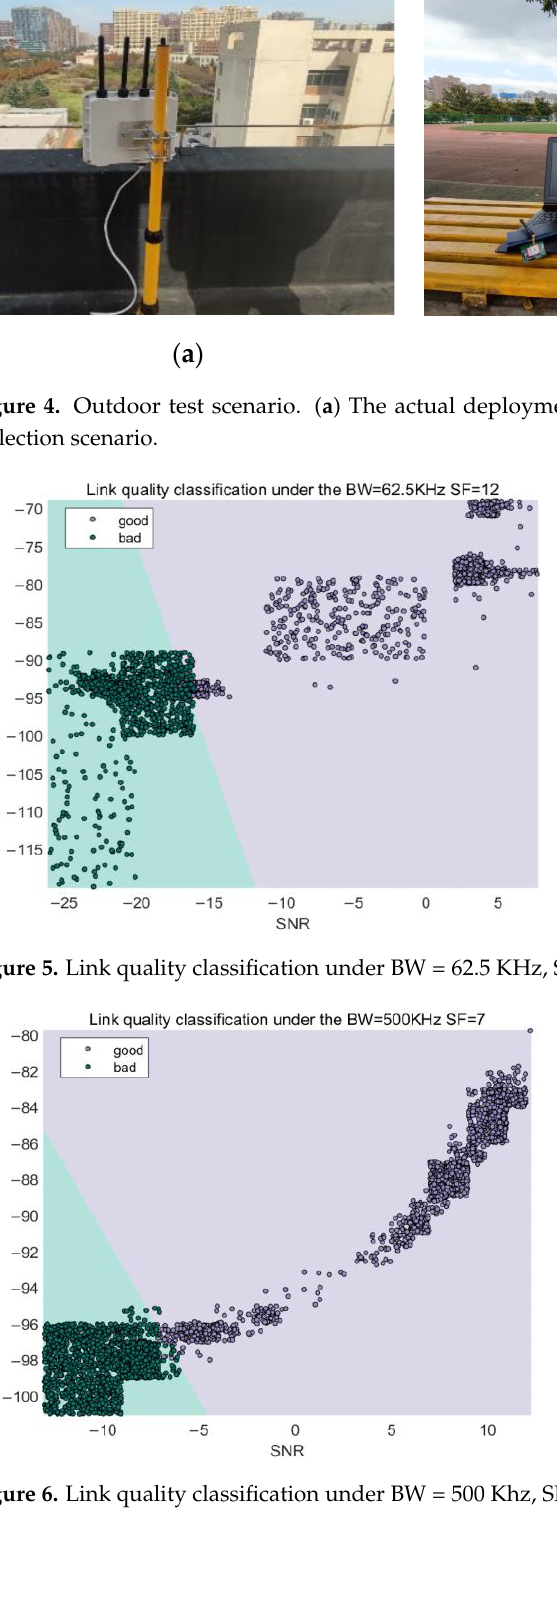
( b ) Figure 7. The optimization process of the model parameters is under BW = 500 khz SF = 12. ( a ) Optimal C solving; ( b ) Optimal b solving. Table 3. Comparison of the different classification models. Method Average Classification Accuracy for the Multiple Rates FSVM 94.24% SVM 92.18% Decision tree